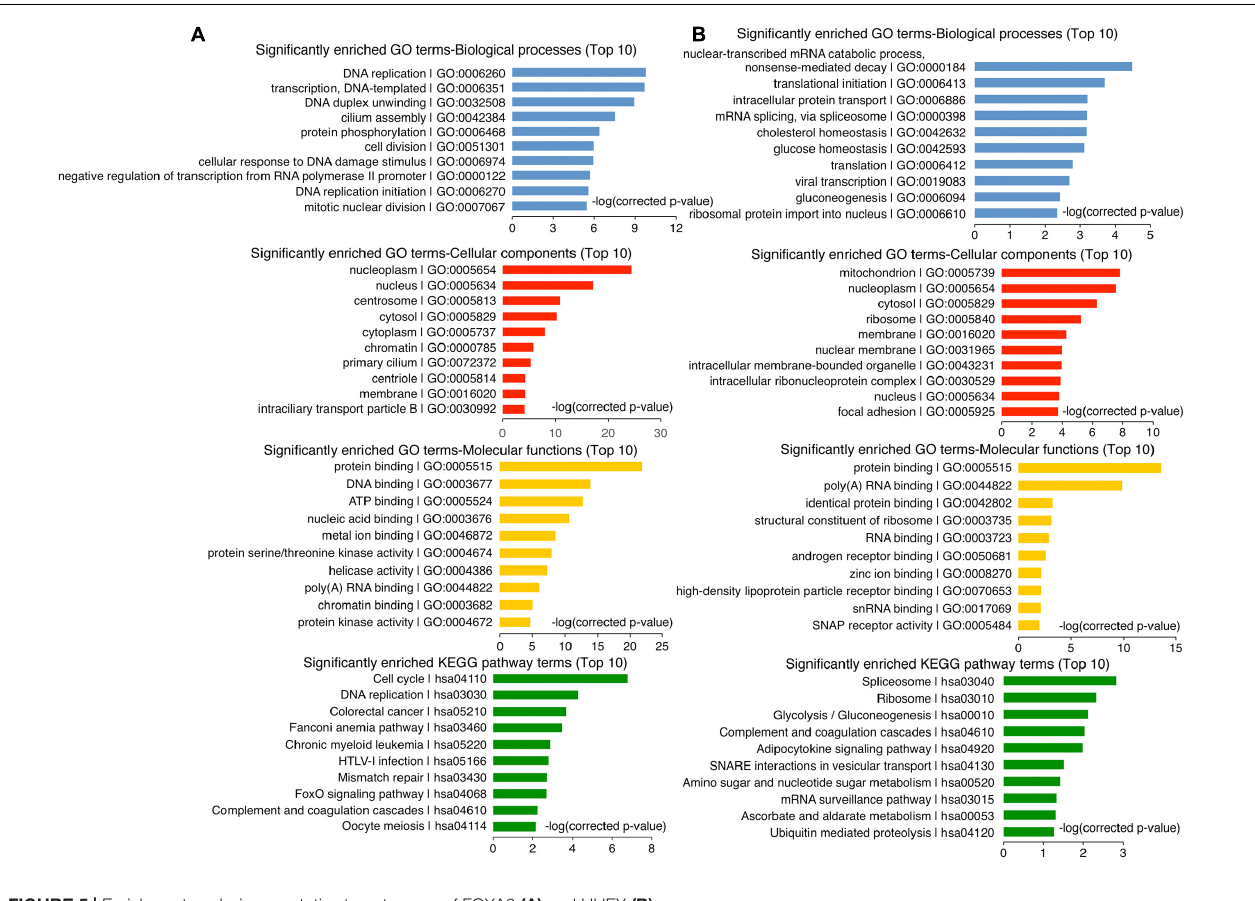
FIGURE 5 | Enrichment analysis on putative target genes of FOXA3 (A) and HHEX (B)